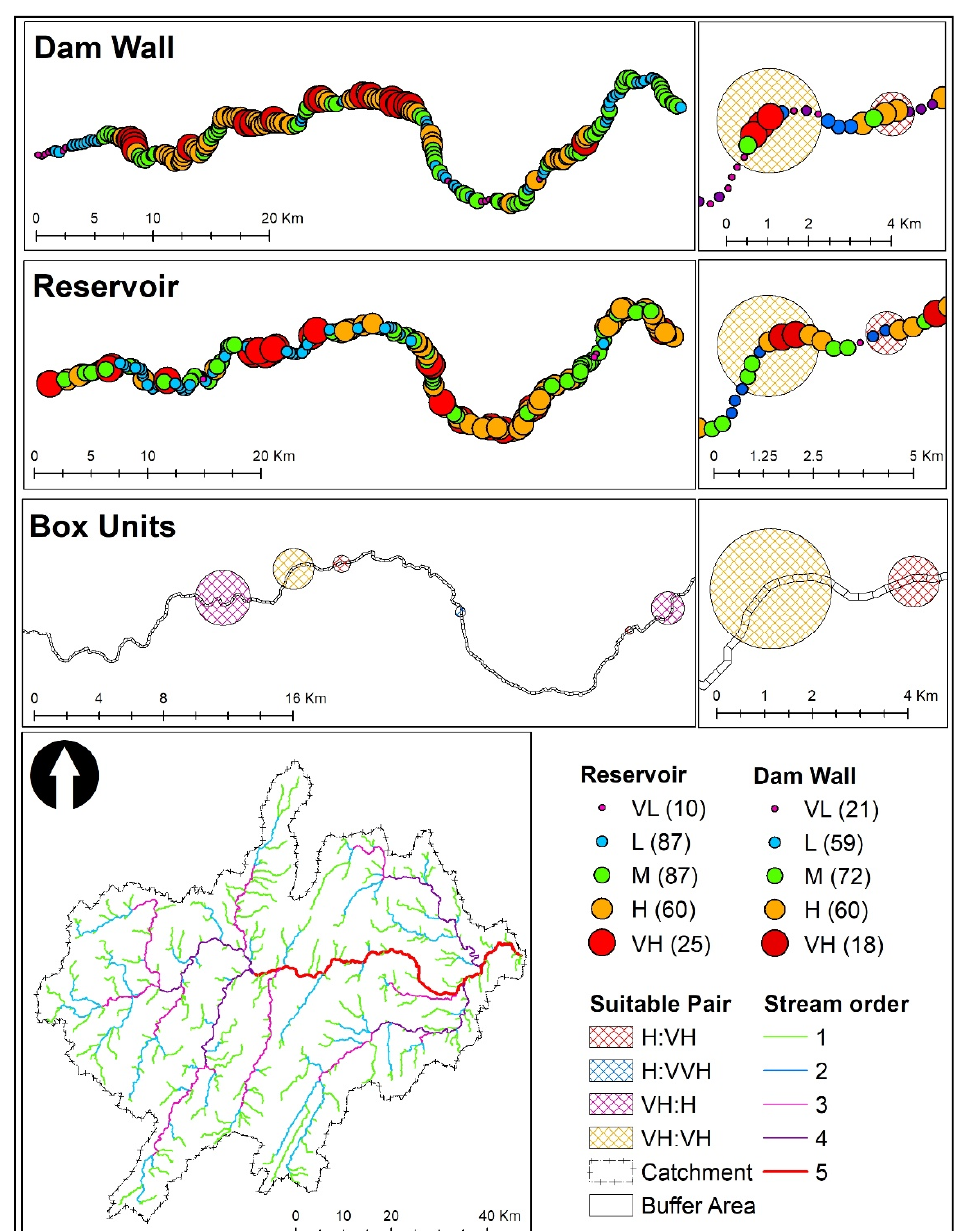
Figure 3. Geographical location of proposed dams’ site with stream order As per the Strahler classification scheme, the Sanghar hill torrent is composed of five stream orders with 5th as the main channel. Dam-A is located upstream of Dam-B on the fifth ordered stream (first criteria). The two suggested sites are approximately 22 km apart. The proposed site for Dam-B is considered as the main dam with a much higher capacity as compare to Dam-A. The reservoir areas of selected sites contain high to very high val- ues of the MRVBF index (second criteria). However, TRI results substantiate low values in the reservoir area and high values for the dam wall (third criteria). The behavior of TRI shows that reservoir comprises of homogeneous topography as shown in Figure 4.